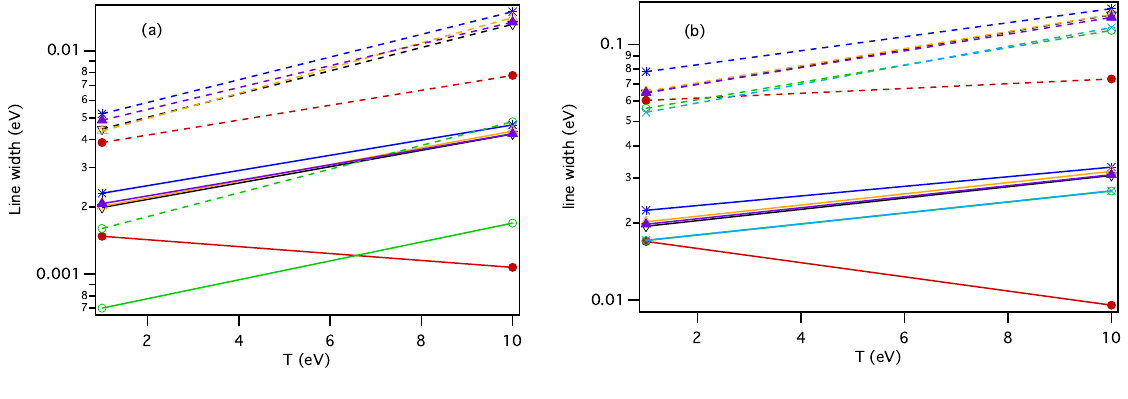
Figure 8. Full line widths at half maximum (FWHM) of the Lyman- α ( a ) and - β ( b ) line in a time-dependent field created by interacting protons versus temperature at n = 10 18 cm − 3 (full lines) and n = 10 19 cm − 3 (dashed lines). Comparisons of the results obtained by the different codes: BinGo (black), Euler–Rodrigues (ER)-simulation (blue), MELS (red), PPP (green), QC-frequency fluctuation model (FFM) (turquoise blue), SimU (yellow) and DM-simulation (purple).